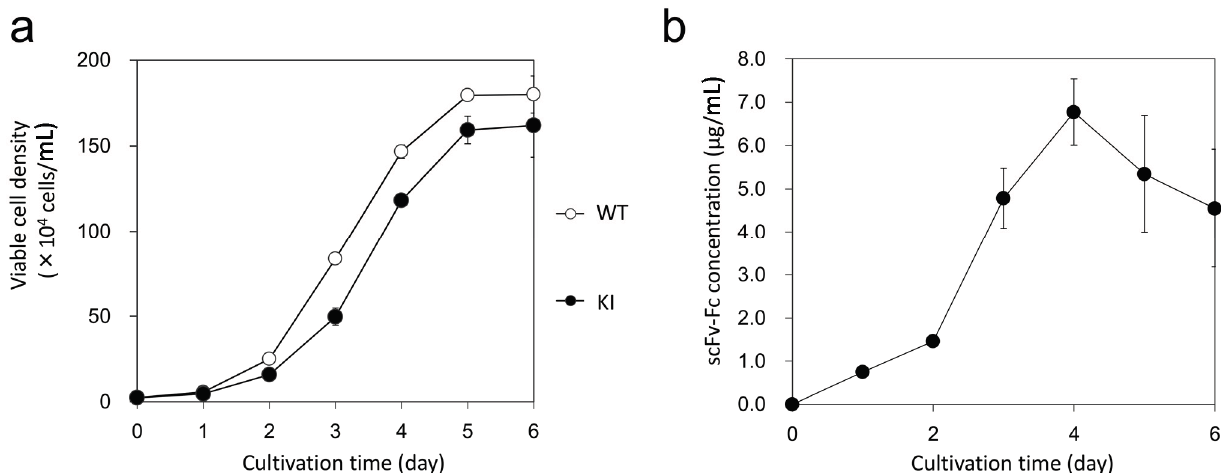
Figure 7. Cell growth and production of scFv-Fc. ( a ) Growth curves of wild-type (WT) and knocked-in (KI) cells. The clone #4-15 was used as the KI cells. Data are expressed as means ± SEM ( n = 3); ( b ) The production rate of recombinant scFv-Fc in the clone #4-15. Data are expressed as means ± SEM ( n =